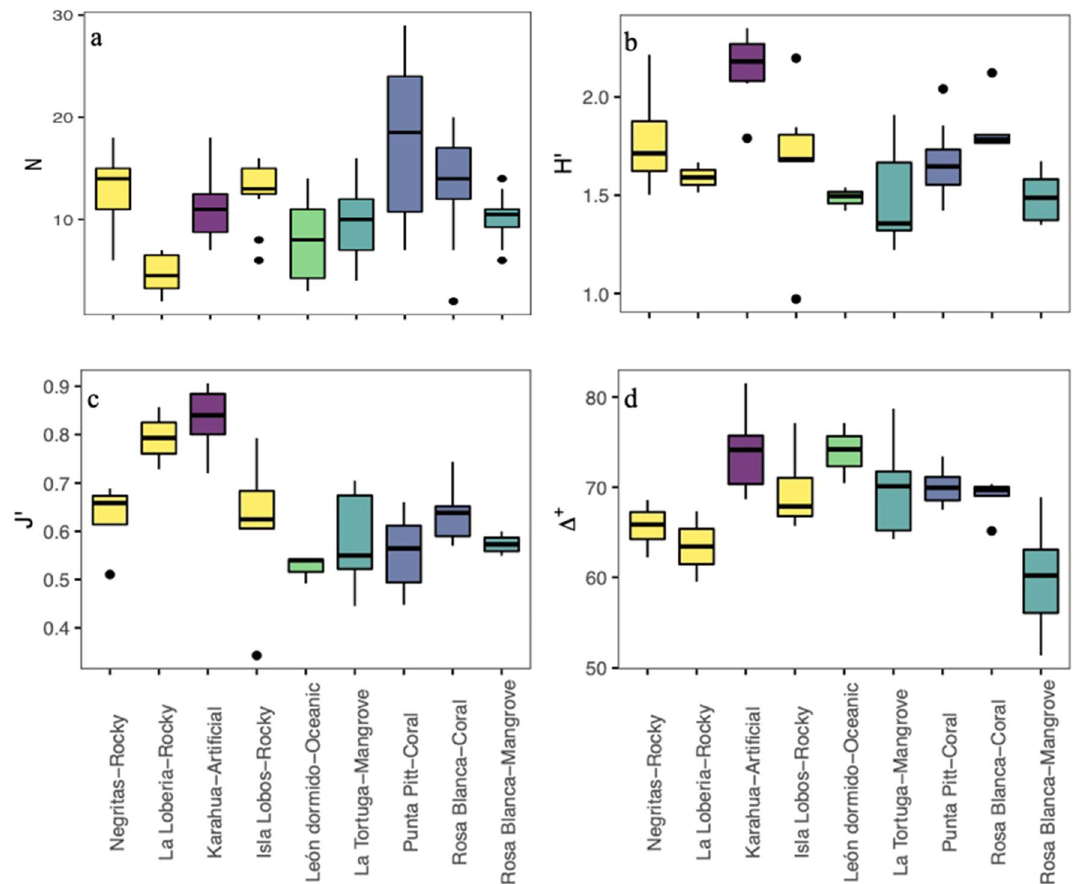
Figure 2. Fish community indices in the different coastal habitat types (sites/substrates) in the southeastern Galapagos Islands: ( a ) species richness (N), ( b ) Shannon index (H ′ ), ( c ) Pielou’s evenness (J ′ ), and ( d ) average taxonomic distinctness